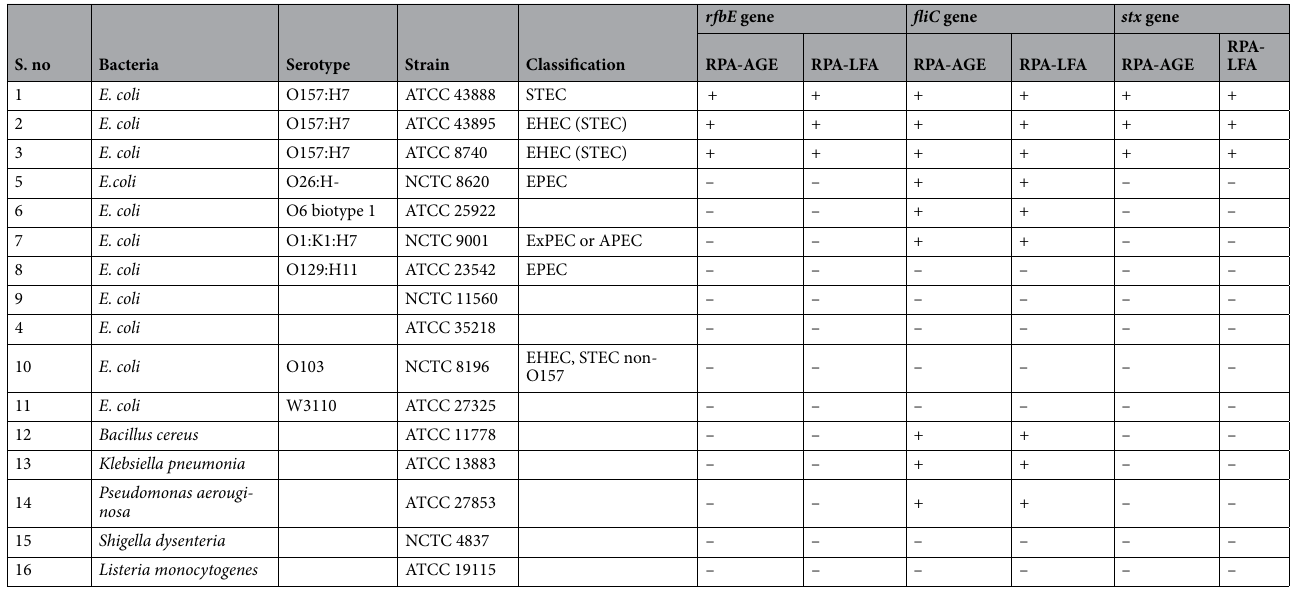
Table 3. Selectivity evaluation of RPA-AGE and RPA-LFA using rfbE and fliC gene